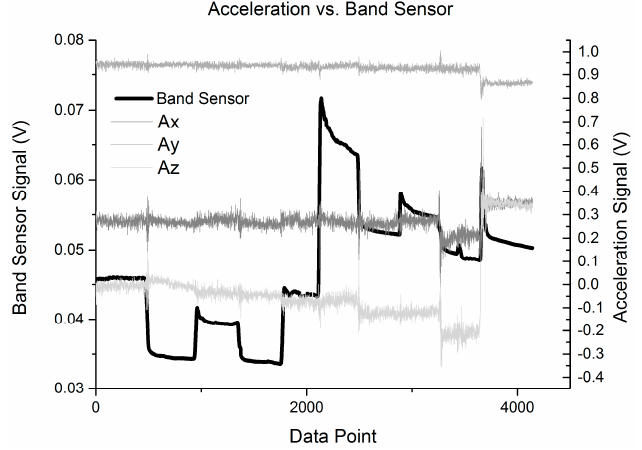
Figure 13. Combined results of the band sensor in the posterior position alonside the STBL smartwatch prototype with 3-axis accelerometer.